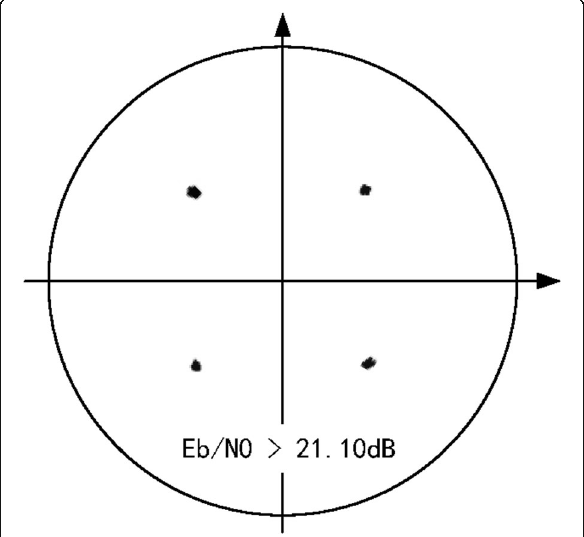
Fig. 13 After filtering (10 dB polarization interference). This figure shows a constellation graph after filtering (10 dB polarization